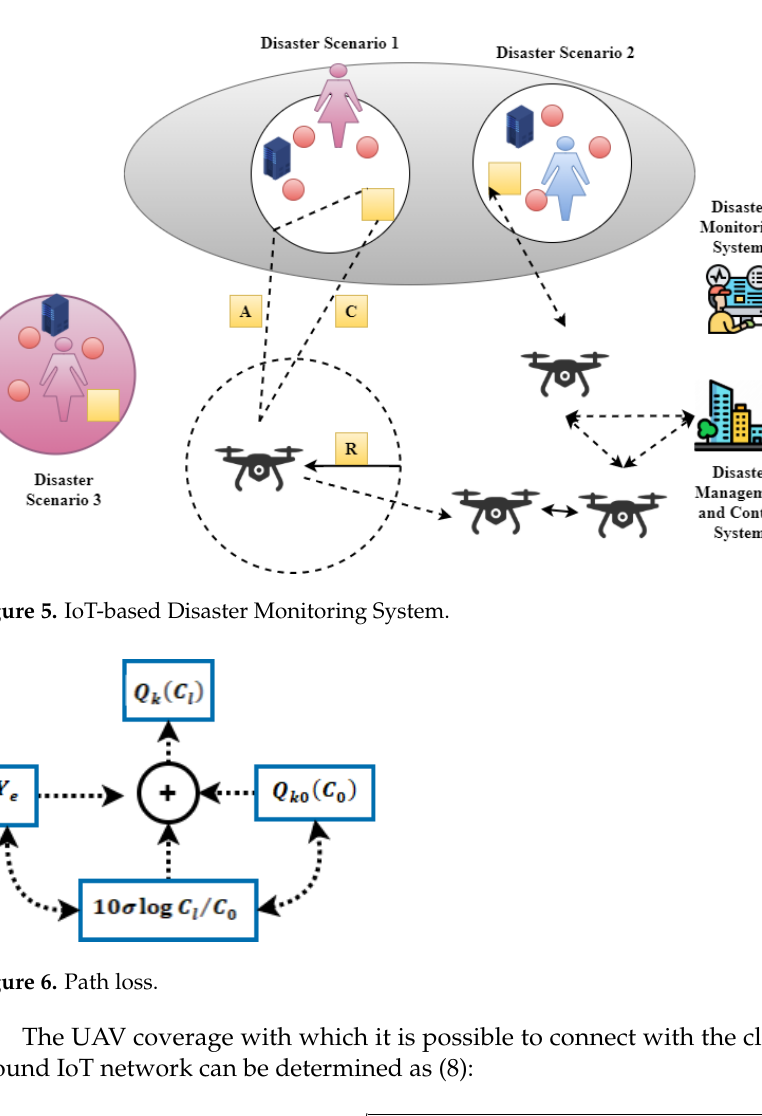
Figure 5. IoT-based Disaster Monitoring System.